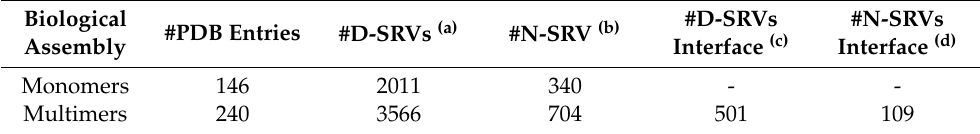
Table 2. Biological assemblies in HVAR3D.